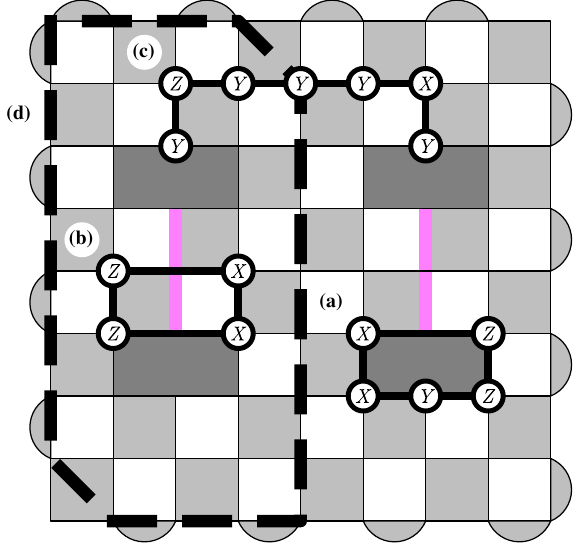
FIG. 3. Two pairs of twist defects on the planar code. Twists appear at the end points of the pink defect lines. (a) The weight- five stabilizer operator of a twist defect, shown up to a phase factor. (b) A modified weight-four stabilizer that lies on the pink line. (c) A logical operator associated with the four twist defects on the lattice. (d) The tensor product of Pauli- X operators on the qubits supported along the dashed line gives the logical operator that anticommutes with that shown at (c).